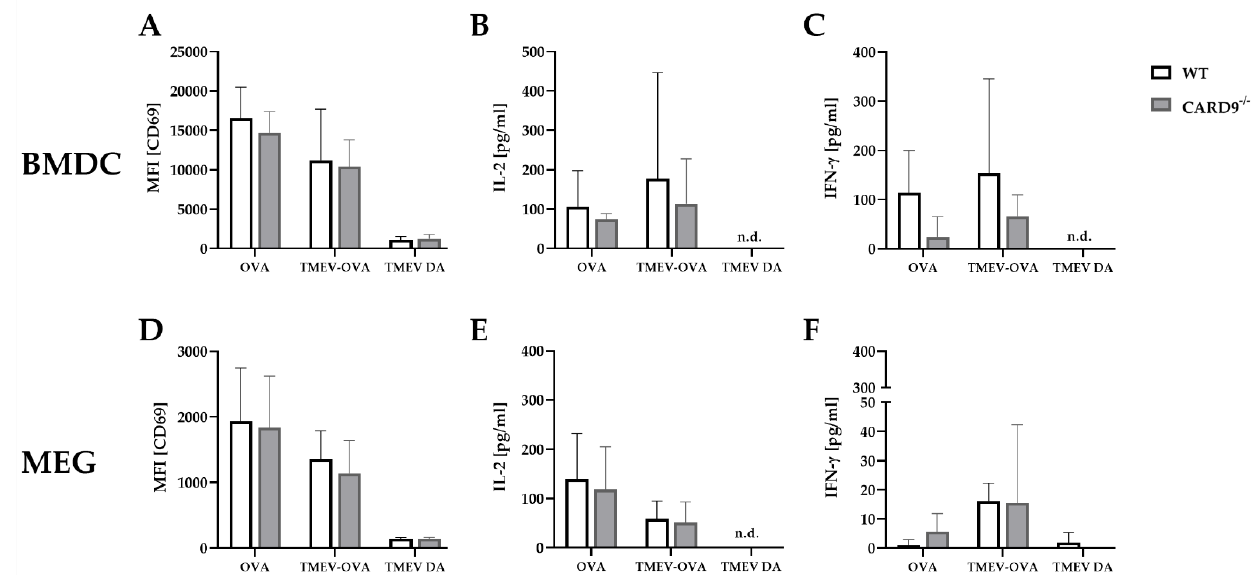
Figure 6. In vitro CD8 + T cell response following incubation with ovalbumin (OVA), TMEV-OVA and TMEV DA of ( A – C ) bone-marrow-derived dendritic cells (BMDCs) or ( D , F ) microglia-enriched glial cell mixtures (MEGs). The mean fluorescence intensity (MFI) of activation marker CD69 gated on CD8 + T cells derived from OT-I mice after co-cultivation with ( A ) BMDCs or ( D ) MEGs was analyzed by flow cytometry. ELISA-based analysis of interleukin 2 (IL-2) and interferon γ (IFN-γ) cytokine production following co-cultivation with ( B , C ) BMDCs or ( E , F ) MEGs. Statistical analysis was done by Mann–Whitney U -test. Data are displayed as mean with SD. n.d. = not detectable.